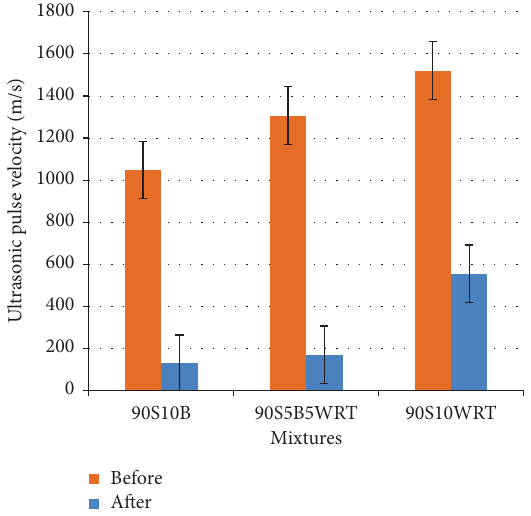
Figure 10: Ultrasonic pulse velocity versus freeze/thaw